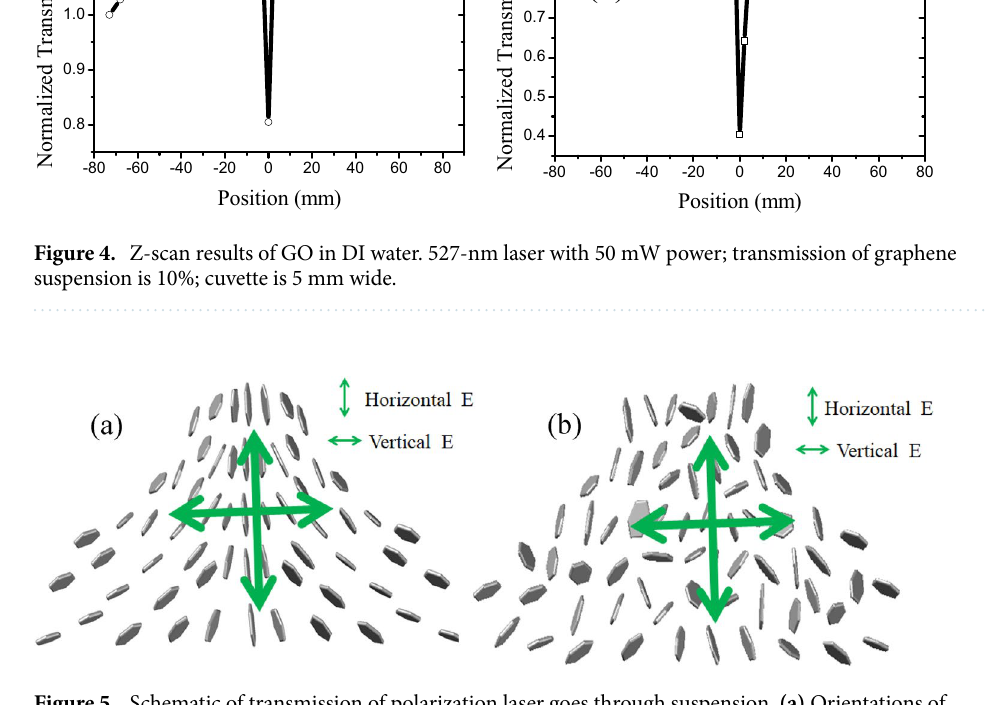
Figure 5. Schematic of transmission of polarization laser goes through suspension. (a) Orientations of graphene flakes in case suspension out of focus; (b) misalignment of graphene flakes when focused laser passes through